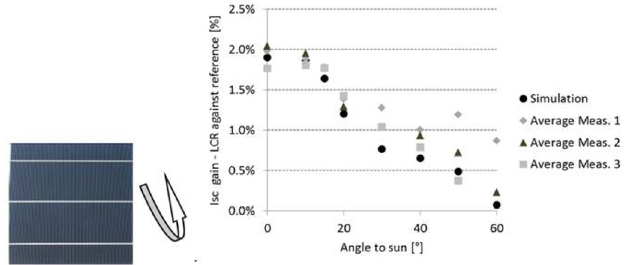
Fig. 11. Angle dependent gain of structured ribbons for hori- zontal orientation of the